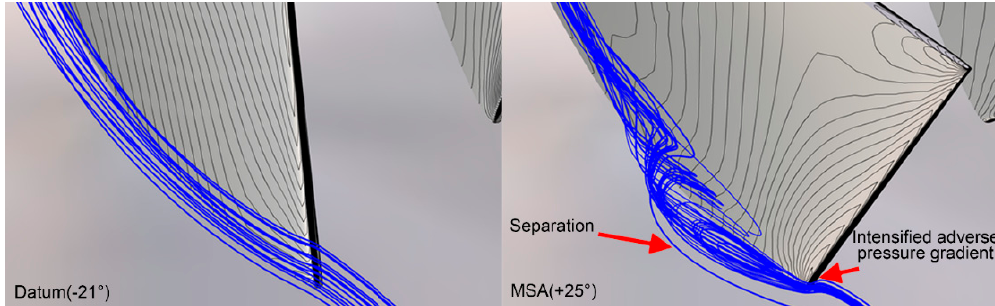
Figure 22. 3D hub streamlines and static pressure isolines on main blade and splitter I.